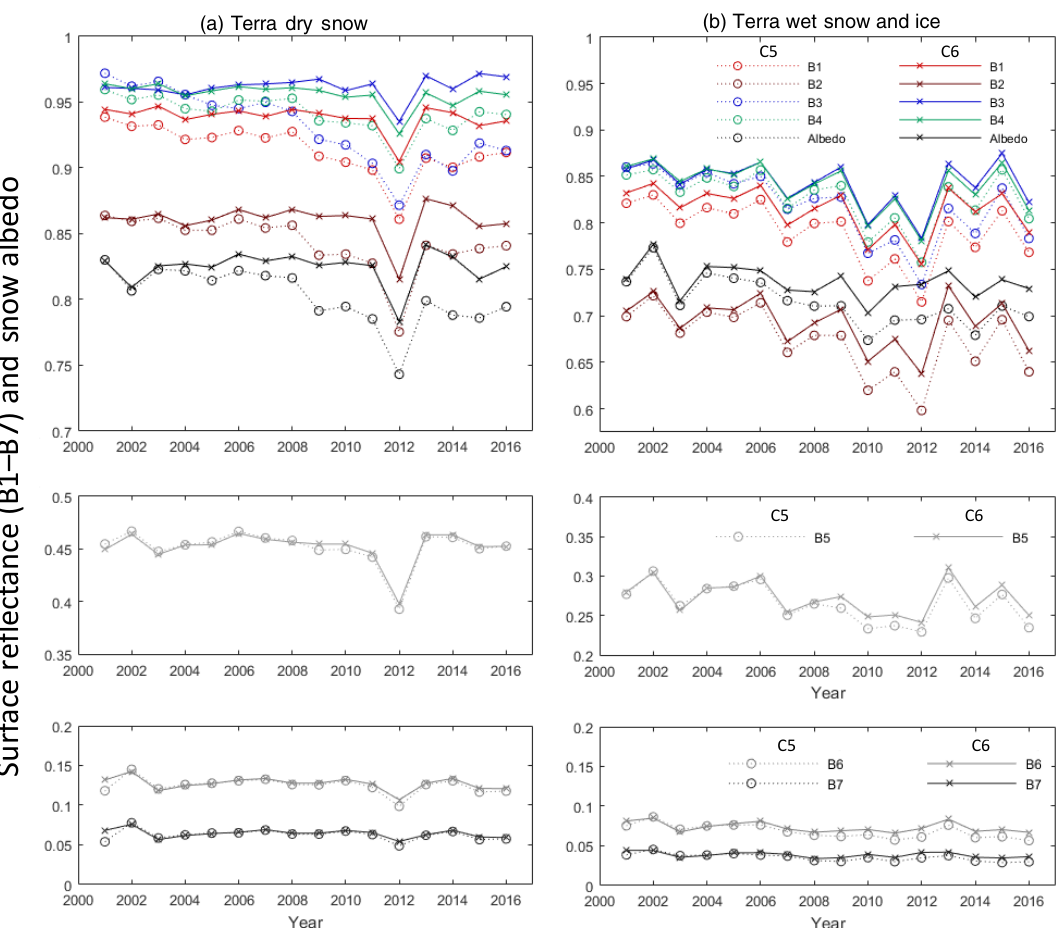
Figure 2. Terra MODIS GrIS C5 (dashed) and C6 (solid) average annual 1 June–31 August MOD09A1 surface reflectance (B1–B7) and MOD10A1 broadband snow albedo, denoted “albedo”, for dry (a) and wet snow and ice (b) . (Note the y -axis scale is different for dry vs. wet snow and ice for B1–4, albedo and